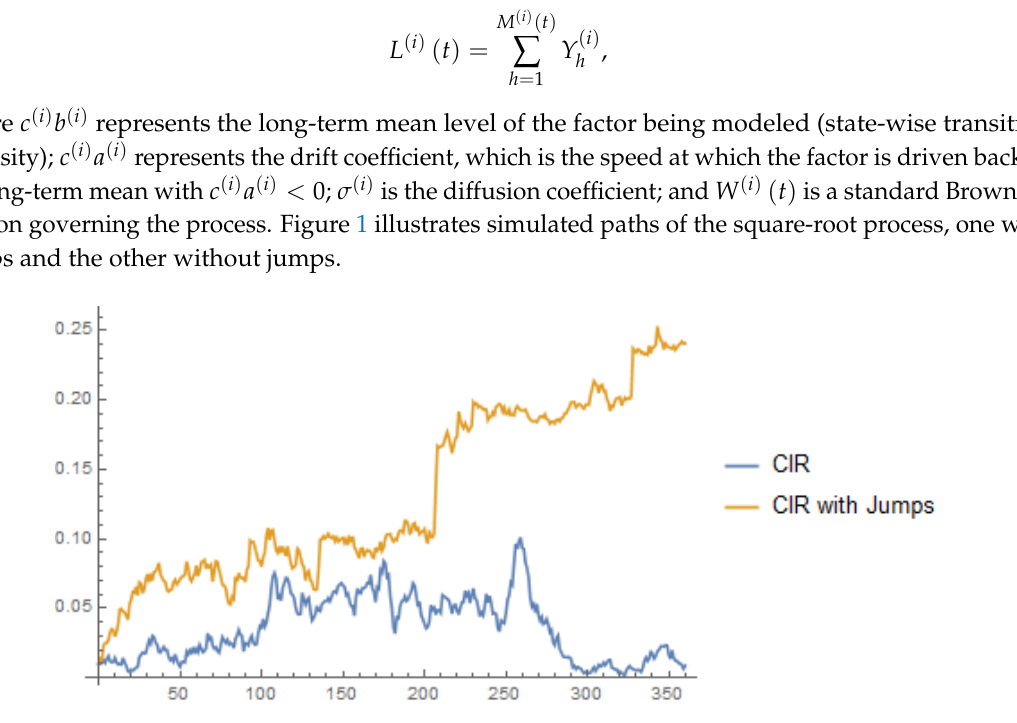
Figure 1. Simulated paths of jump-diffusion vs non-jump-diffusion